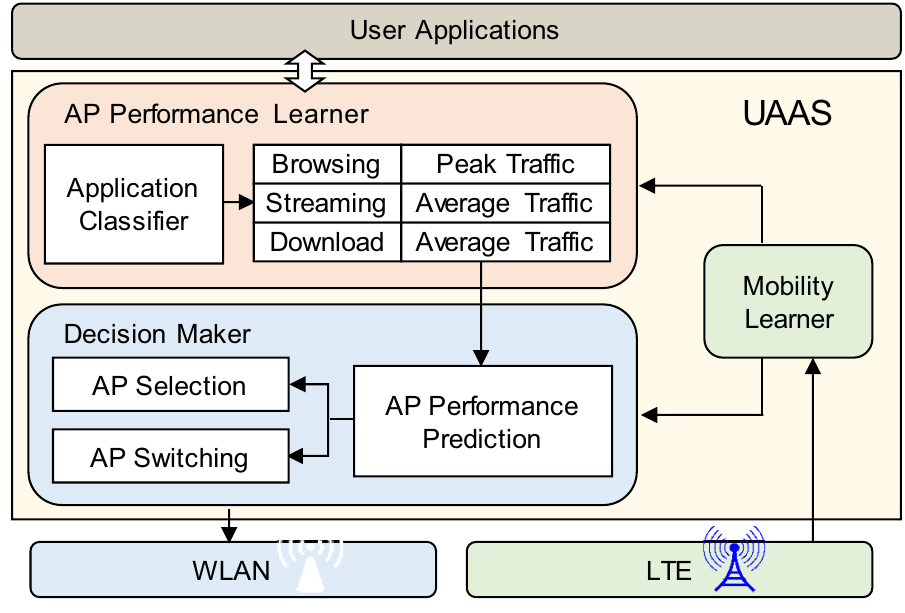
Fig 6. Architecture of our UAAS